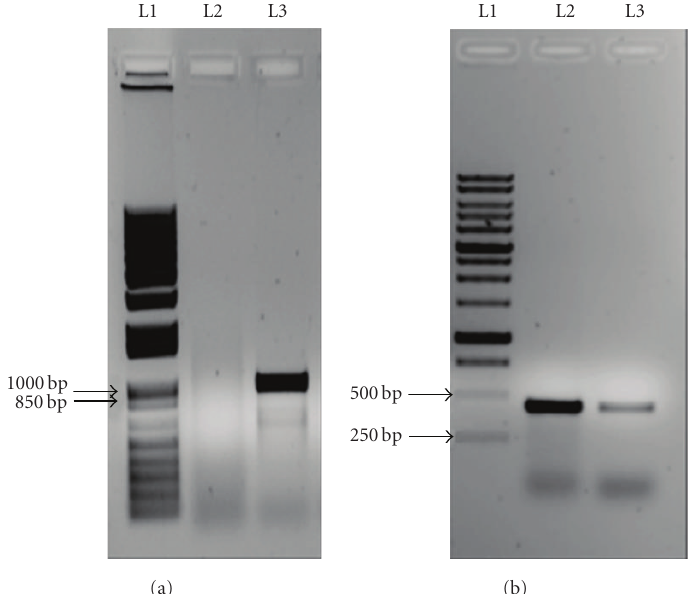
Figure 2: PCR amplification of mecA gene products (a) and the genes that code PVL (b) visualized on gel electrophoresis. (a) Lanes (L): L1—mecA gene PCR kit; L2—Patient; L3—Positive Control. (b) Lanes (L): L1—PVL gene PCR kit; L2—Patient; L3—Positive